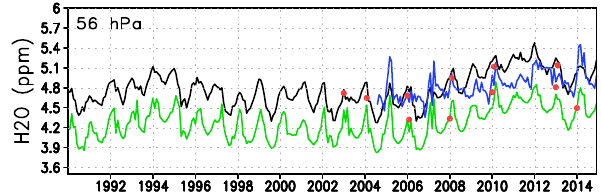
Figure 4. Sodankylä monthly mean water vapour mixing ratio from FinROSE (black), MLS (blue), ECMWF ERA-Interim (green), and soundings (red dots) at 56hPa between 1990 and 2014.